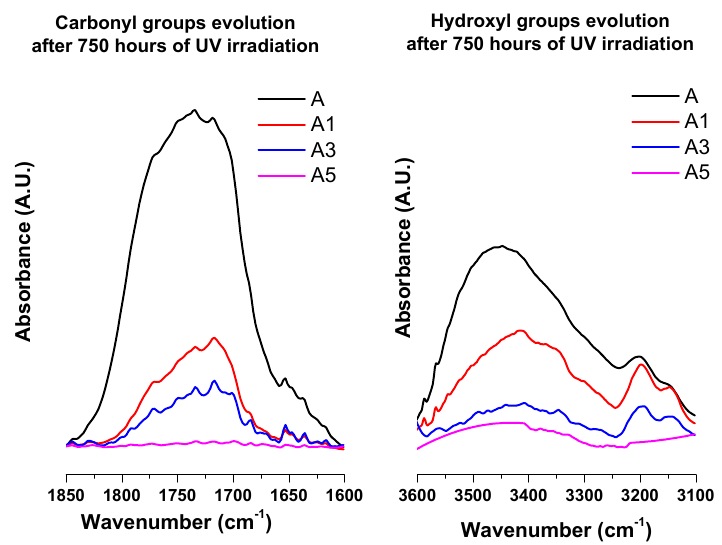
Figure 14. Carbonyl and Hydroxyl IR absorption bands of A, A1, A3 and A5 samples after an irradiation time of 750 h.